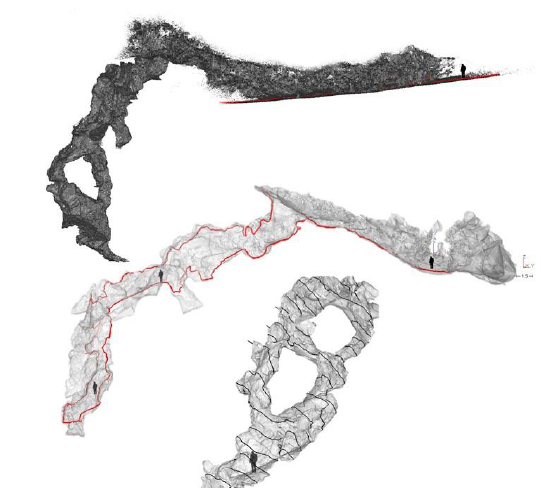
Figure 16. (Above) the rough cloud represented with z axis vertical; (centre) a continuous surface model showing the trajectory and human dimensions to understand the extension of internal spaces; (below) an example of extraction of automatical vertical section